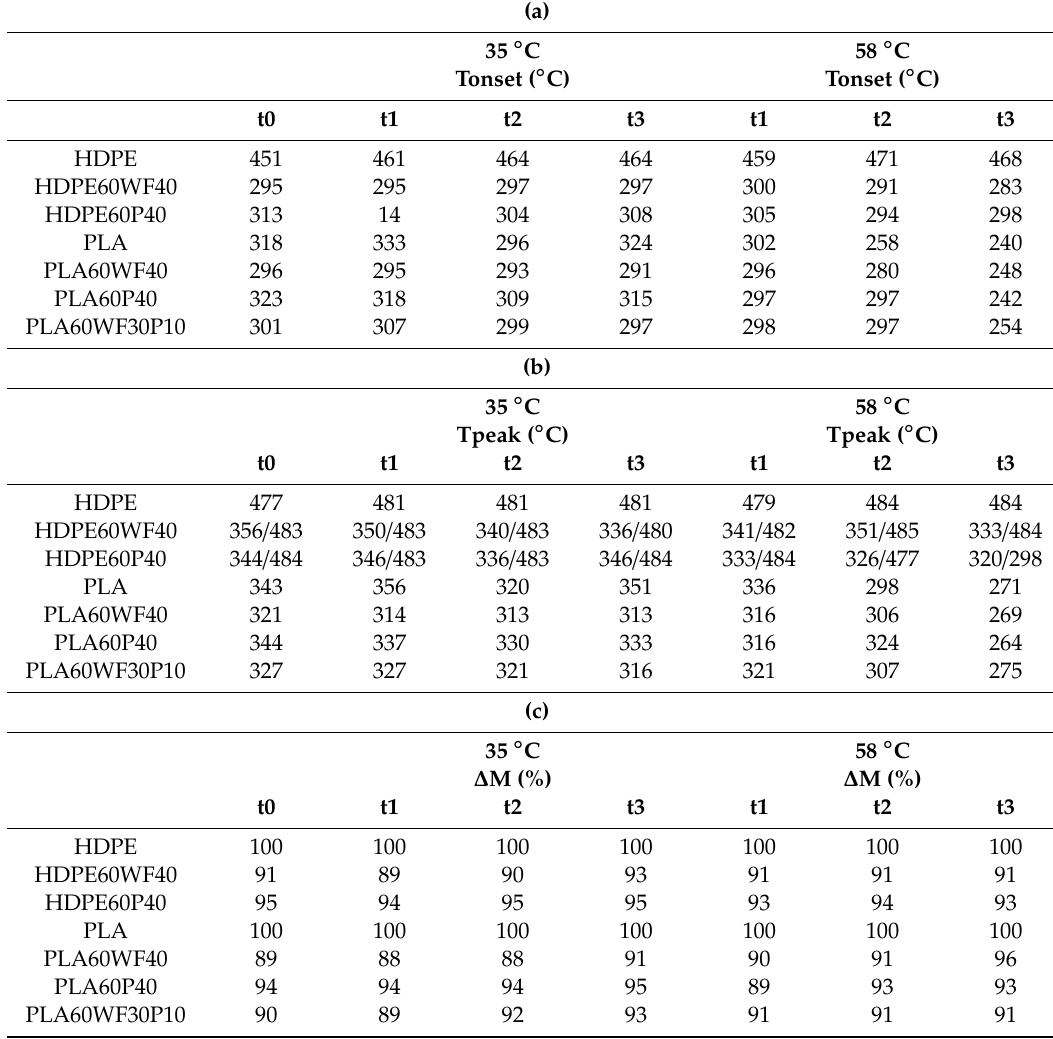
Table 3. TGA results for HDPE and PLA based composites after three months buried at 35 ◦ C